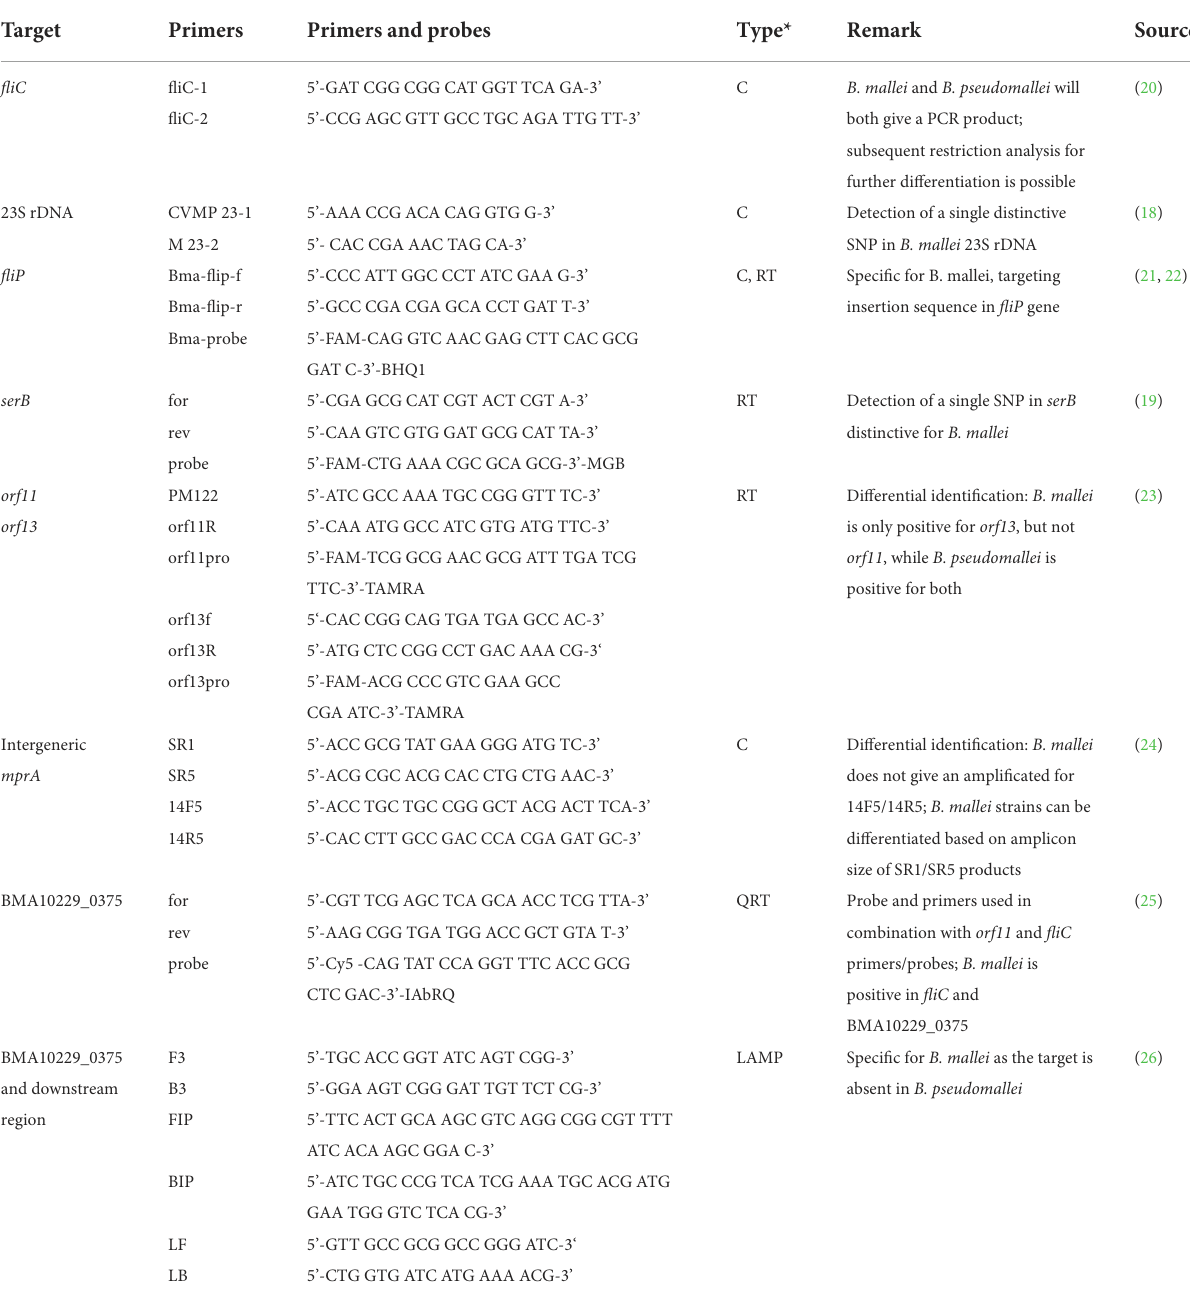
TABLE 1 PCR-based methods for differentiation of Burkholderia